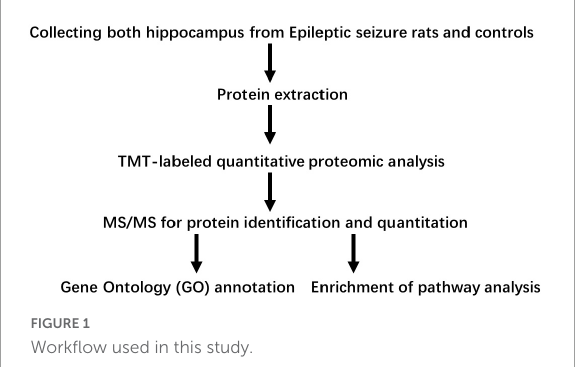
FIGURE1 Workflow used in this